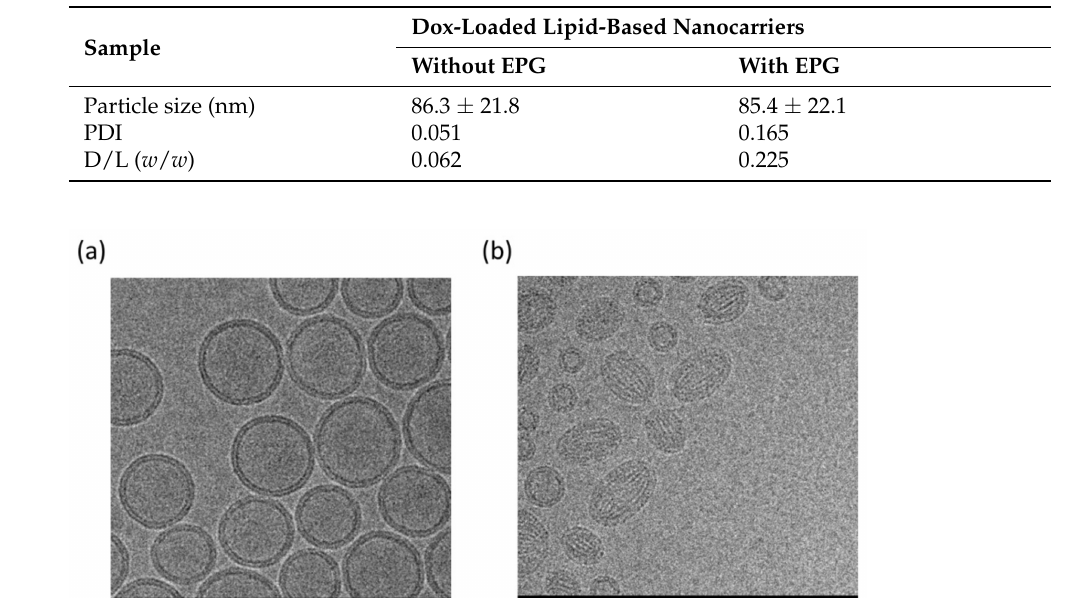
Table 1. Characteristics of Dox-loaded lipid-based nanocarriers produced with or without EPG. Data are expressed as the mean ± SD ( n = 3).